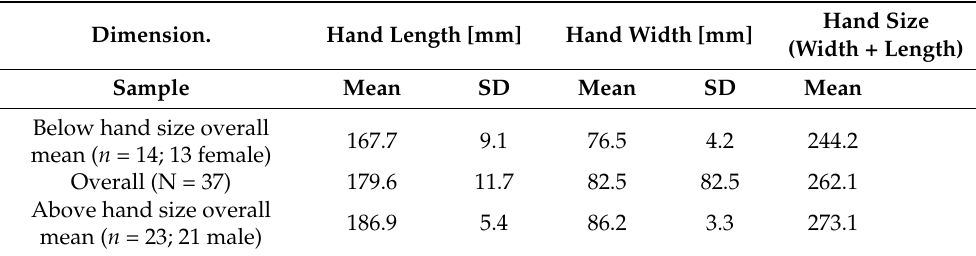
Hand Size (Width + Length)